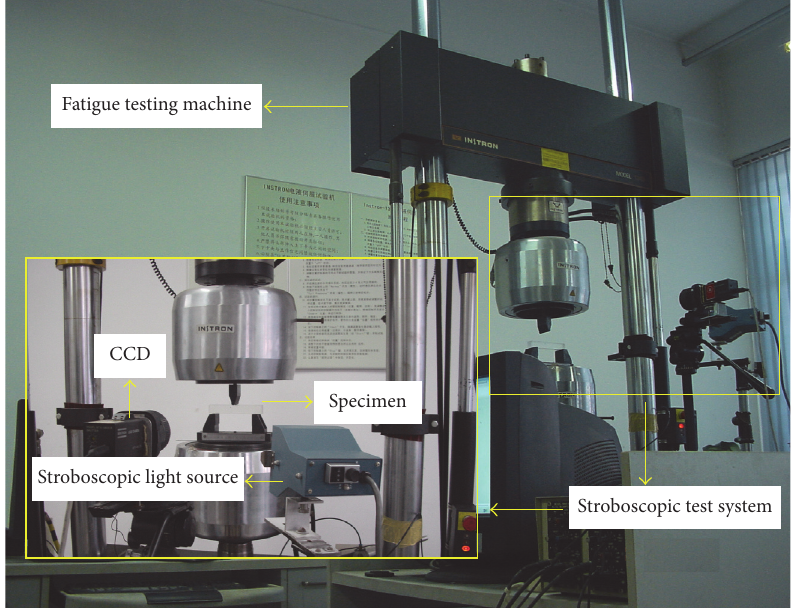
Figure 2: Fatigue test system for the stroboscope method.